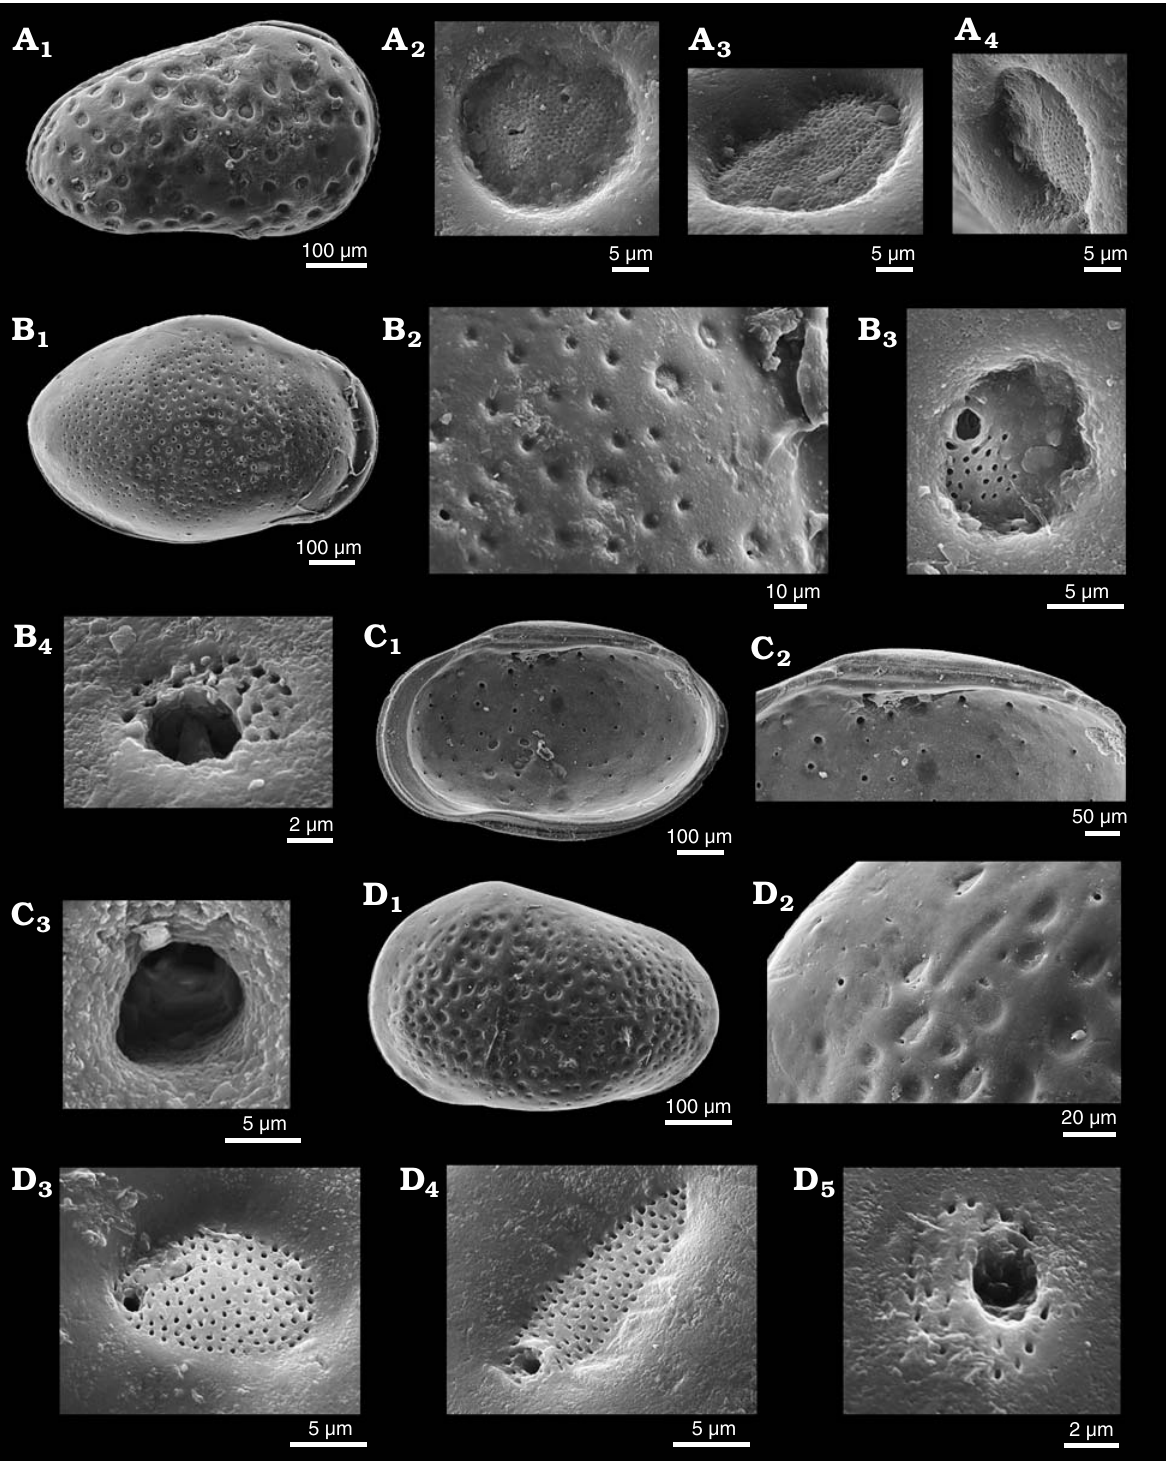
Fig. 3. Sieve-type normal pore canals (StPC) in Aphelocythere and Camptocythere spp. A . Aphelocythere perforata Plumhoff, 1963, from Borehole Wesendorf 51a, 1031–1035 m, NW Germany, Upper Aalenian. SMF Xe 5608 (Plumhoff Collection), carapace in external right view (A 1 ), macro StPC (StPC-M) (A 2 –A 4 ). B , C . Campto cythere praecox Triebel, 1950 from Borehole Hambühren WA 2, 341 m, NW Germany, Leioceras opalinum Zone, Lower Aalenian (Braun Jura α ). B . Paratype, SMF Xe 1448, male right valve in external view (B 1 ), mid-anterior area behind marginal rim, ornamentation and pores (large and small) (B 2 ), StPC-M with a peripheral large pore (B 3 ), micro StPC (StPC-m) (B 4 ). C . Paratype, SMF Xe 1448, male right valve in internal view (C 1 ), hinge (C 2 ), StPC-m (C 3 ). D . Camptocythere media Triebel, 1950 from Borehole Altencelle 1014, 212/16 m, NW Germany, Upper Aalenian (Braun Jura β ). Paratype, SMF Xe 1513, female left valve in external view (D 1 ), detail, antero-dorsal area, ornamentation and pores (large and small) (D 2 ), round StPC-M (D 3 ), elongate StPC-M (D 4 ), StPC-m (D 5